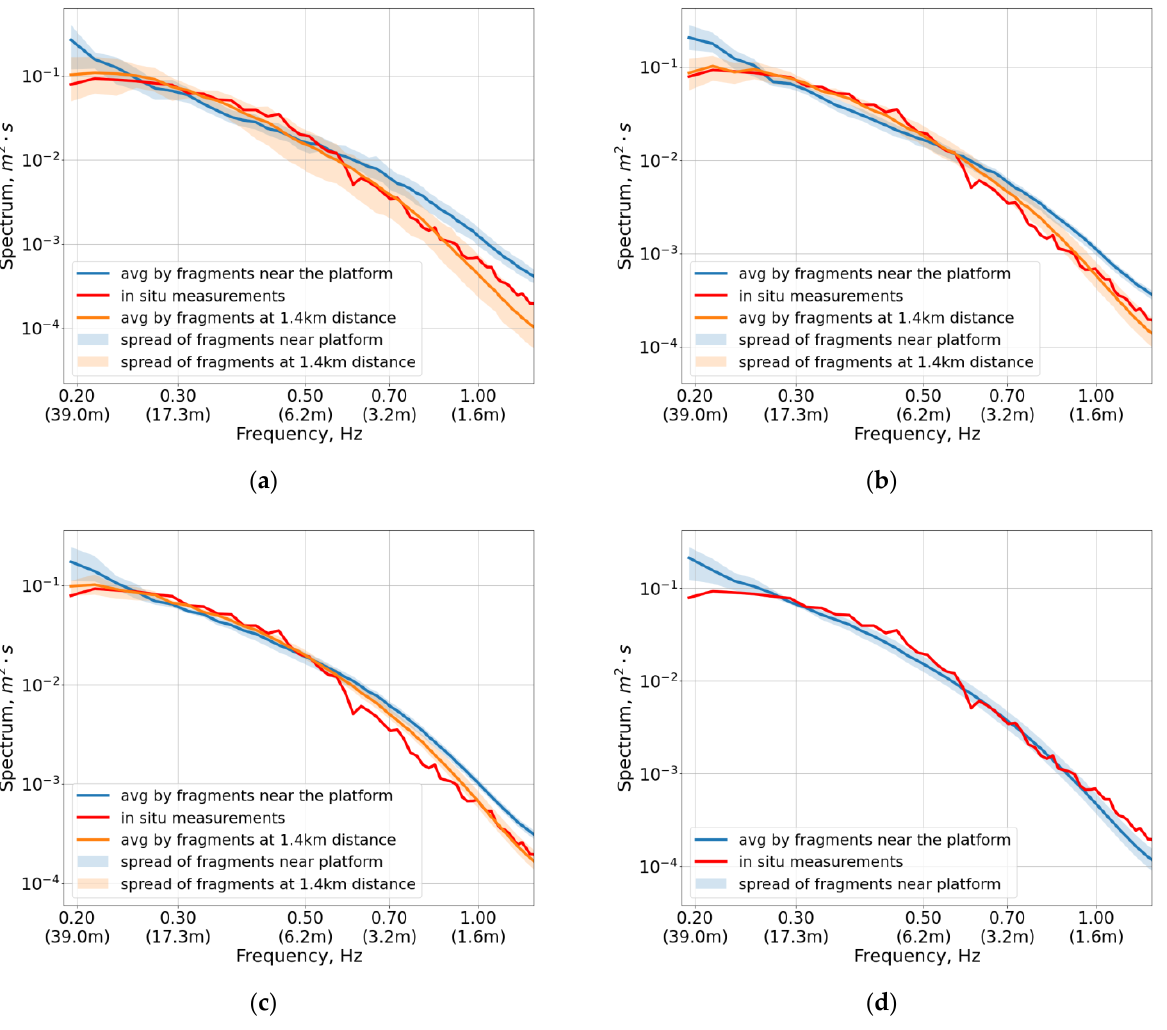
Figure 11. Comparison of integral one-dimensional spectra retrieved from satellite images with the integral spectrum obtained from in situ data processing. Fragment sizes 1024 ( a ), 2048 ( b ), 4096 ( c ), 8192 ( d